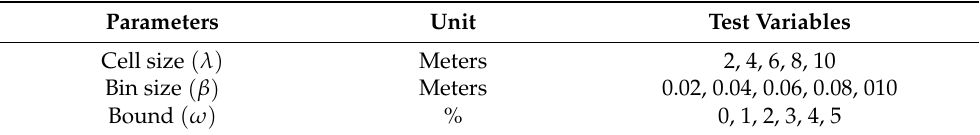
Table 2. Test variables for sensitivity